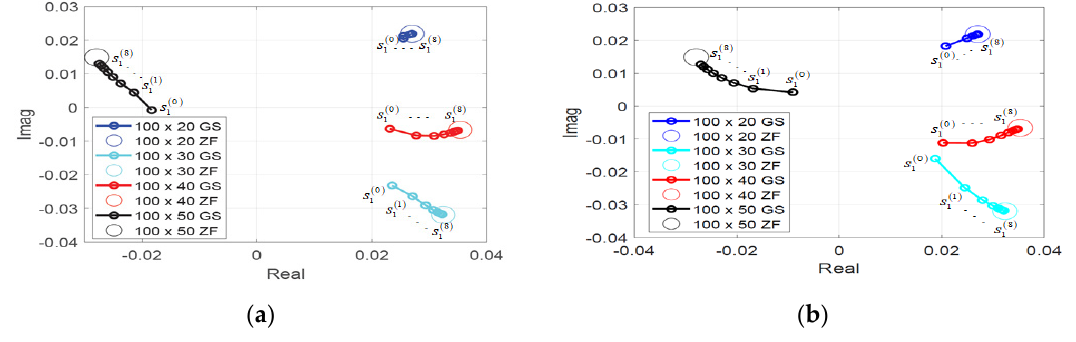
( i ) ( ) i Figure 2. The s s in complex plane with respect to the number of iterations in 100 20 × , 100 30 × , m in complex plane with respect to the number of iterations in 100 Figure 2. The m 100 × 40, and 100 × 50 systems: ( a ) An initial solution for s 100 40 × , and 100 50 × systems: ( a ) An initial solution for